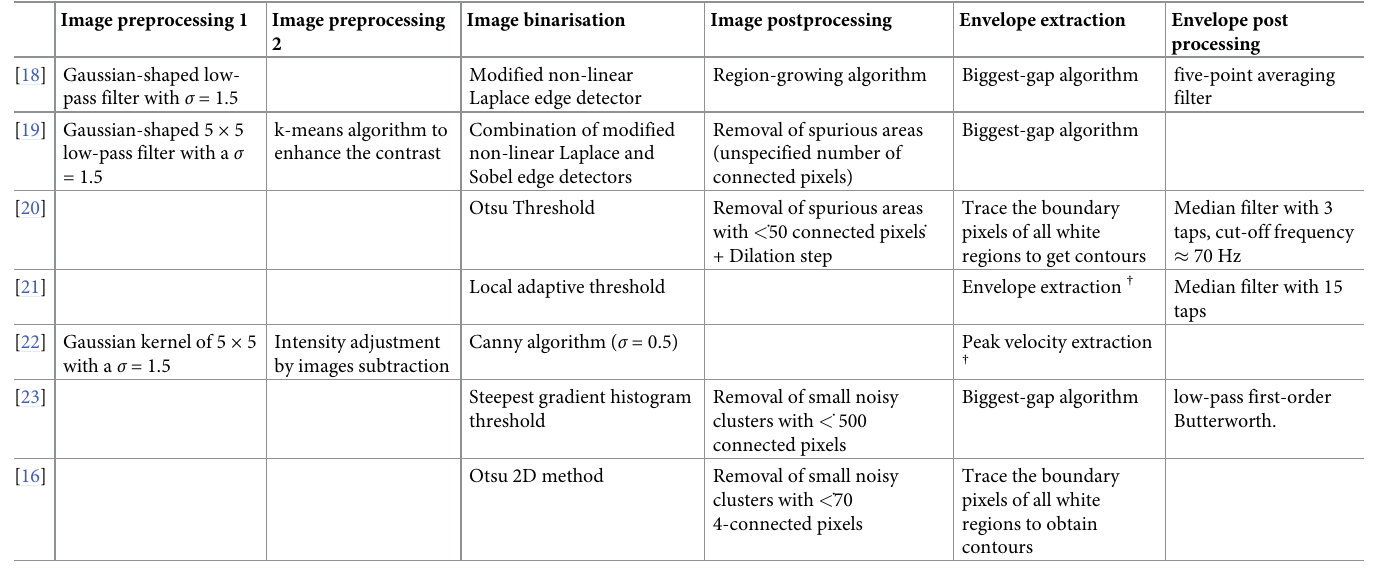
Table 1. Main publications on the automated tracing of the Doppler velocity envelope. Image preprocessing 1 Image preprocessing